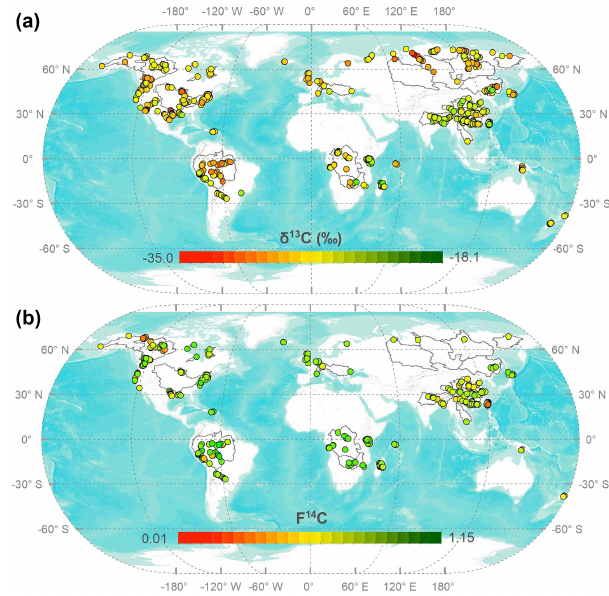
Figure 1. Overview of the dual carbon isotope data of MORE- POC v1.1. (a) Fm 14 C values; (b) δ 13 C values. Note that an average value is presented when several samples have been collected at the same